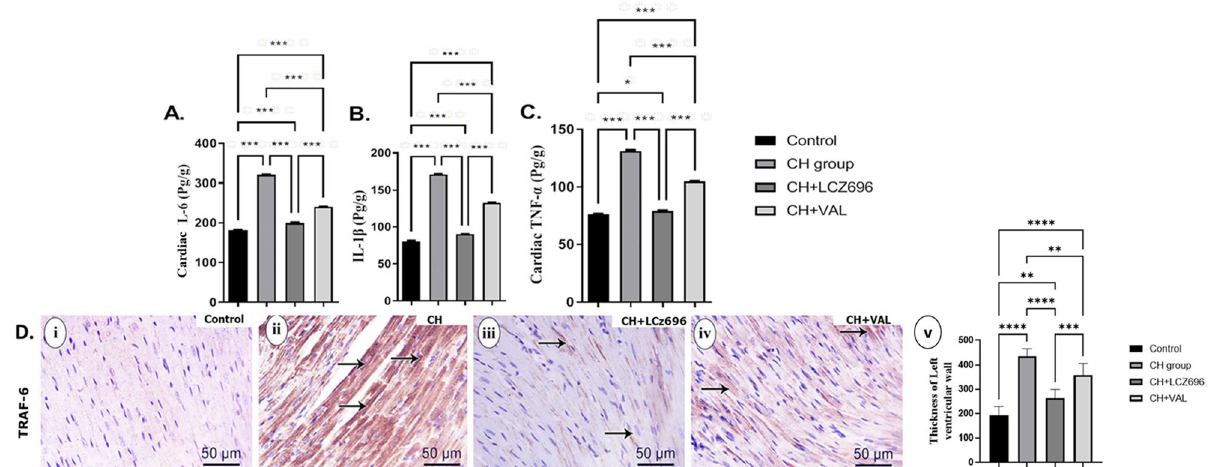
Figure 2. The effect of the LCZ696 and VAL administration on the level of the cardiac inflammatory markers ( A – D ). ( A ) cardiac IL-6 level (Pg/g), ( B ) cardiac IL-1β level (Pg/g), ( C ) cardiac TNF-α (Pg/g) level, ( D ) (i–v) representative photomicrographs showing the estimation of immunohistochemical staining of TRAF-6 in rat cardiac tissues of the different experimental groups (i) Control group, (ii) CH group, (iii) CH + LCZ696 group, (iv) CH + VAL group, and (v) a bar chart demonstrates the changes in the area % of TRAF-6 immune-positive cells of the different experimental groups. Values are mean of 6 rats per group ± S.E.M * p < 0.05; ** p < 0.01; *** p < 0.001. Group means were compared by one-way analysis of variance (ANOVA) followed by Tukey post hoc tests for multiple